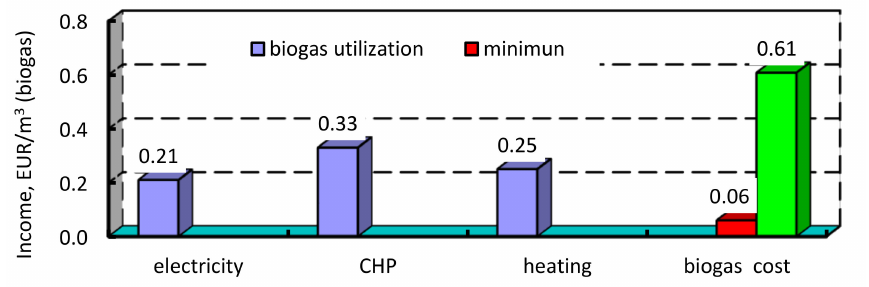
Figure 13. Income from the use of one cubic meter of biogas.